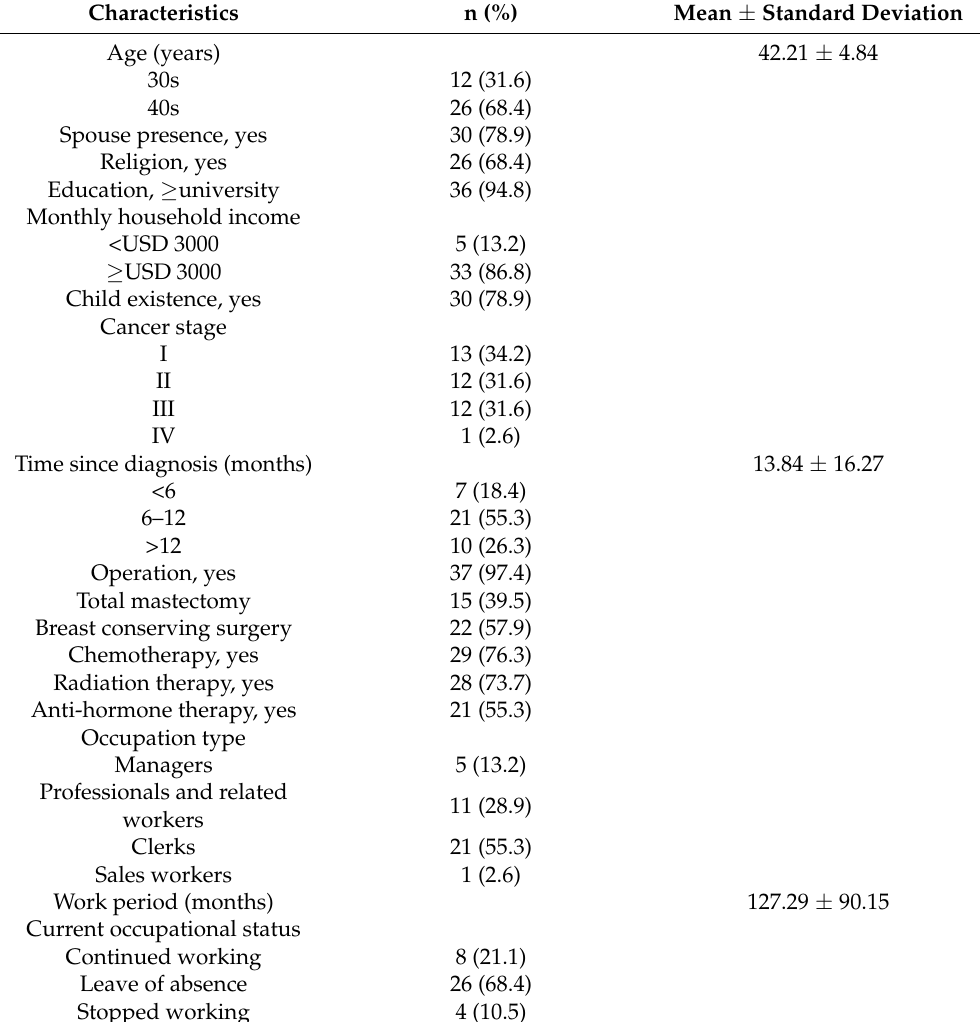
Table 1. General characteristics of this study (n =